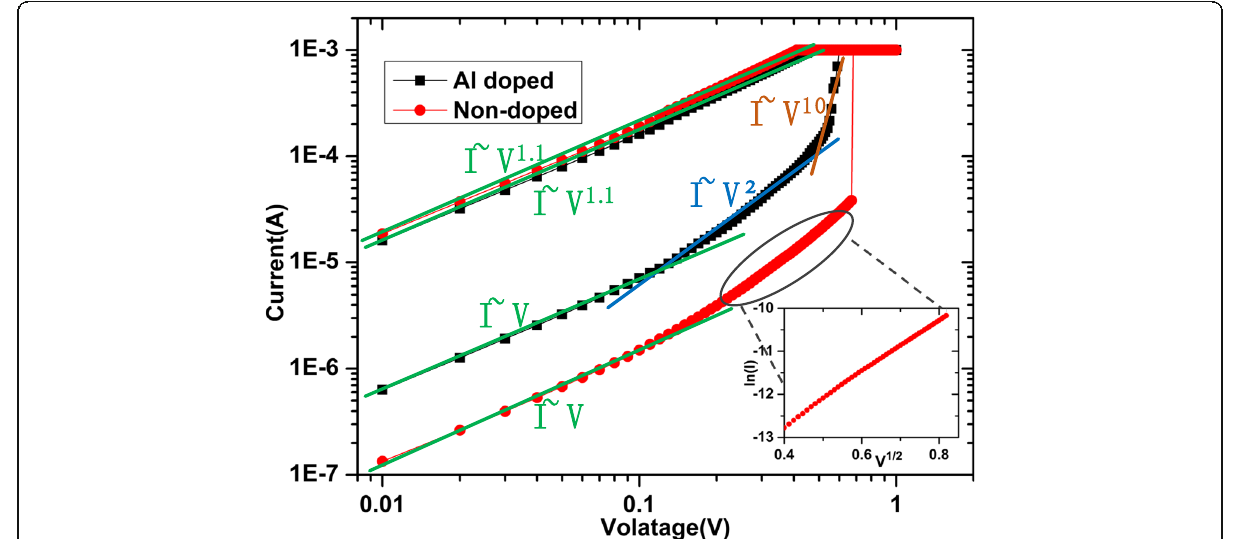
Fig. 4 The curve fitting of SET process in the double logarithmic